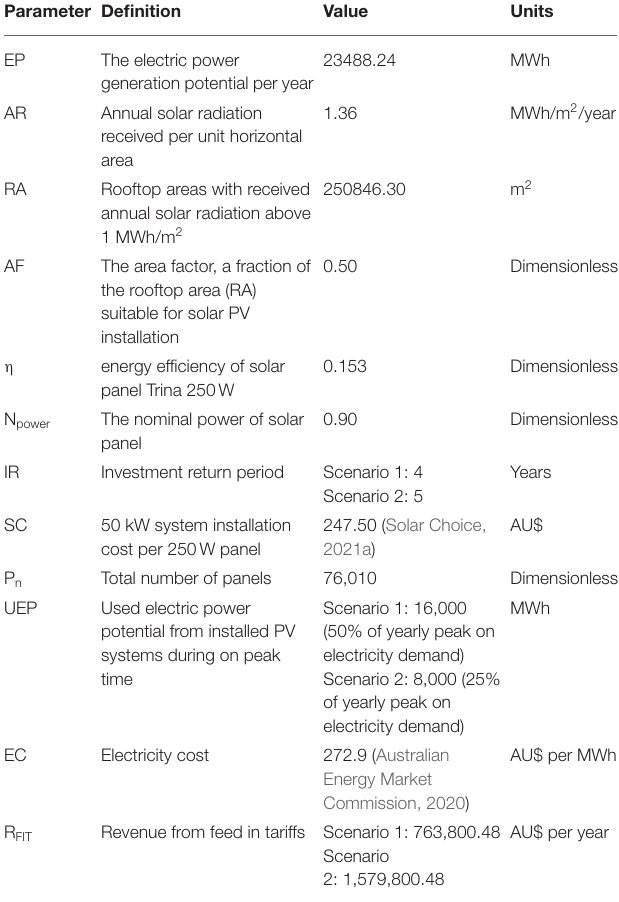
TABLE 4 | Definition and values of parameters used in Equations (5) and